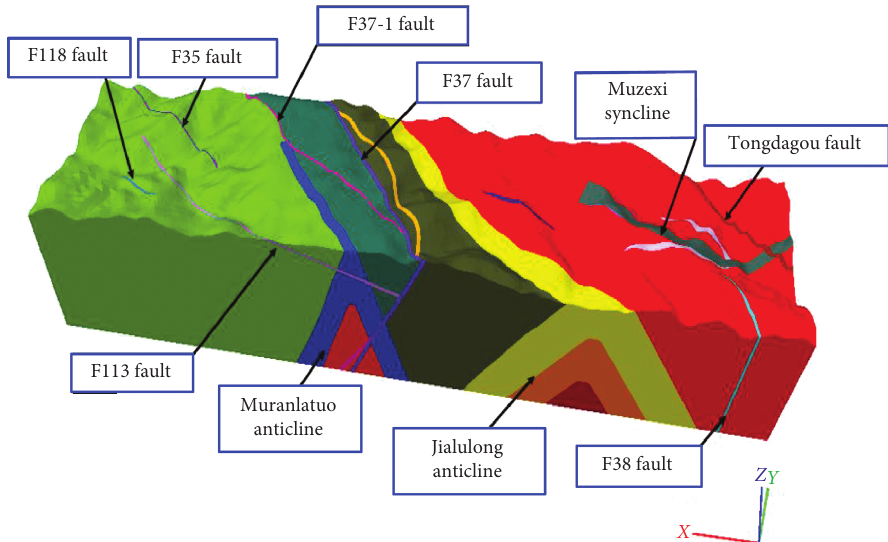
Figure 5: Three-dimensional numerical model of the tunnel in Sichuan-Tibet Railway.